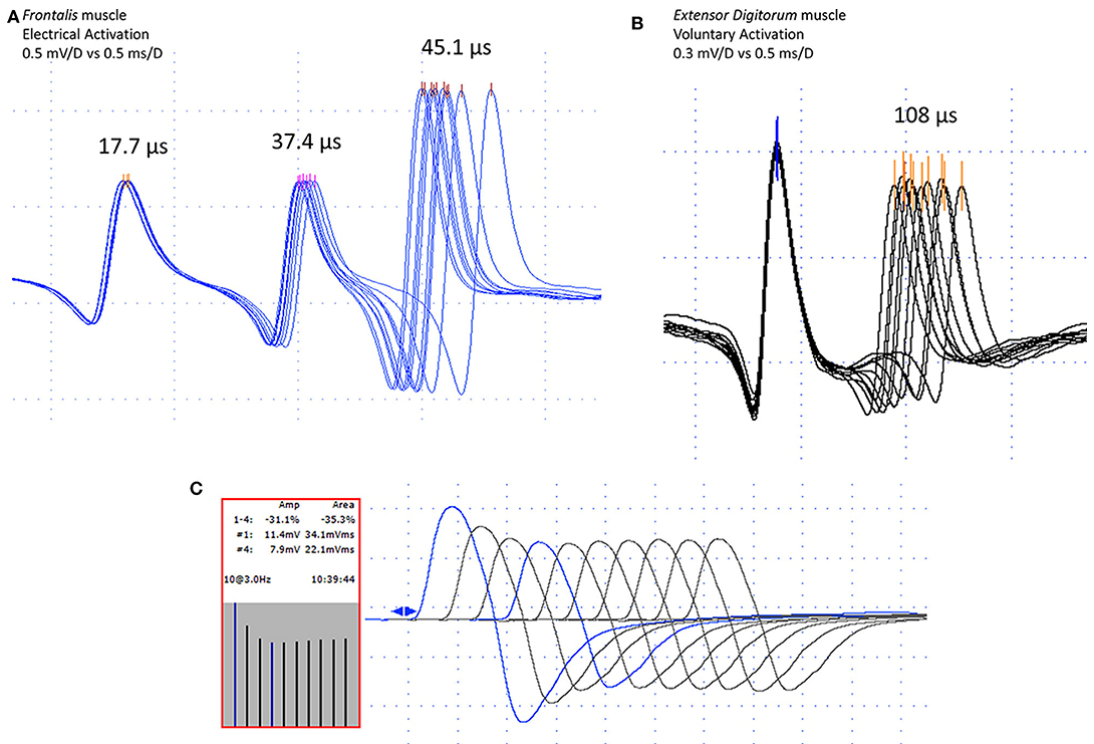
Figure 11. “Ex ungue leonem”: flawless recordings of normal and abnormal stimulation jitter, abnormal volitional jitter, and the paradigmatic U-shaped CMAP decrement, from an article with co-author Professor E. Stalberg. Copyright © 2020 Kouyoumdjian, Paiva, and Stålberg. From: Kouyoumdjian JA, Paiva GP, and Stålberg E. Concentric Needle Jitter in 97 Myasthenia Gravis Patients. Front Neurol. 2020;11:600680. Published 2020 Nov 13. doi:10.3389/fneur.2020.600680, under CC BY license.